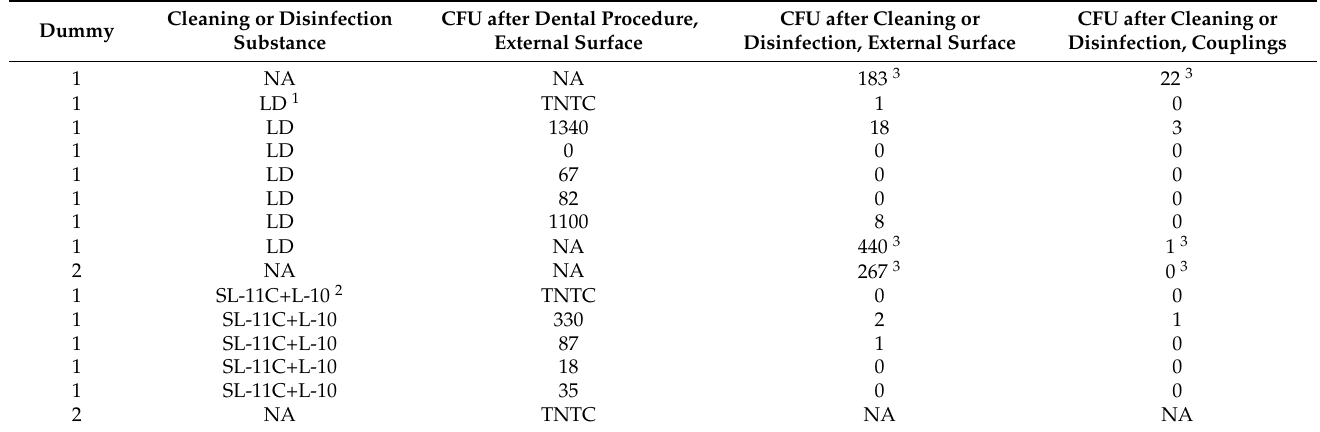
Table 5. Bacterial load of dummies (handpieces not used during dental procedure, illustrating extra handpieces placed close by (approximately 70 cm from the patient’s oral cavity) if needed during the procedure. Day 1 dummy 1 was put in place approximately 10 min before the first patient of the day, day 2 dummies 1 and 2 were put in place approximately 10 min before the first patient of the day. Dummy 1 was sampled and cleaned or disinfected after each patient whilst dummy 2 was not cleaned or disinfected, and sampled only after the last patient included for the day. CFU is given in total CFU/external surface and CFU/coupling